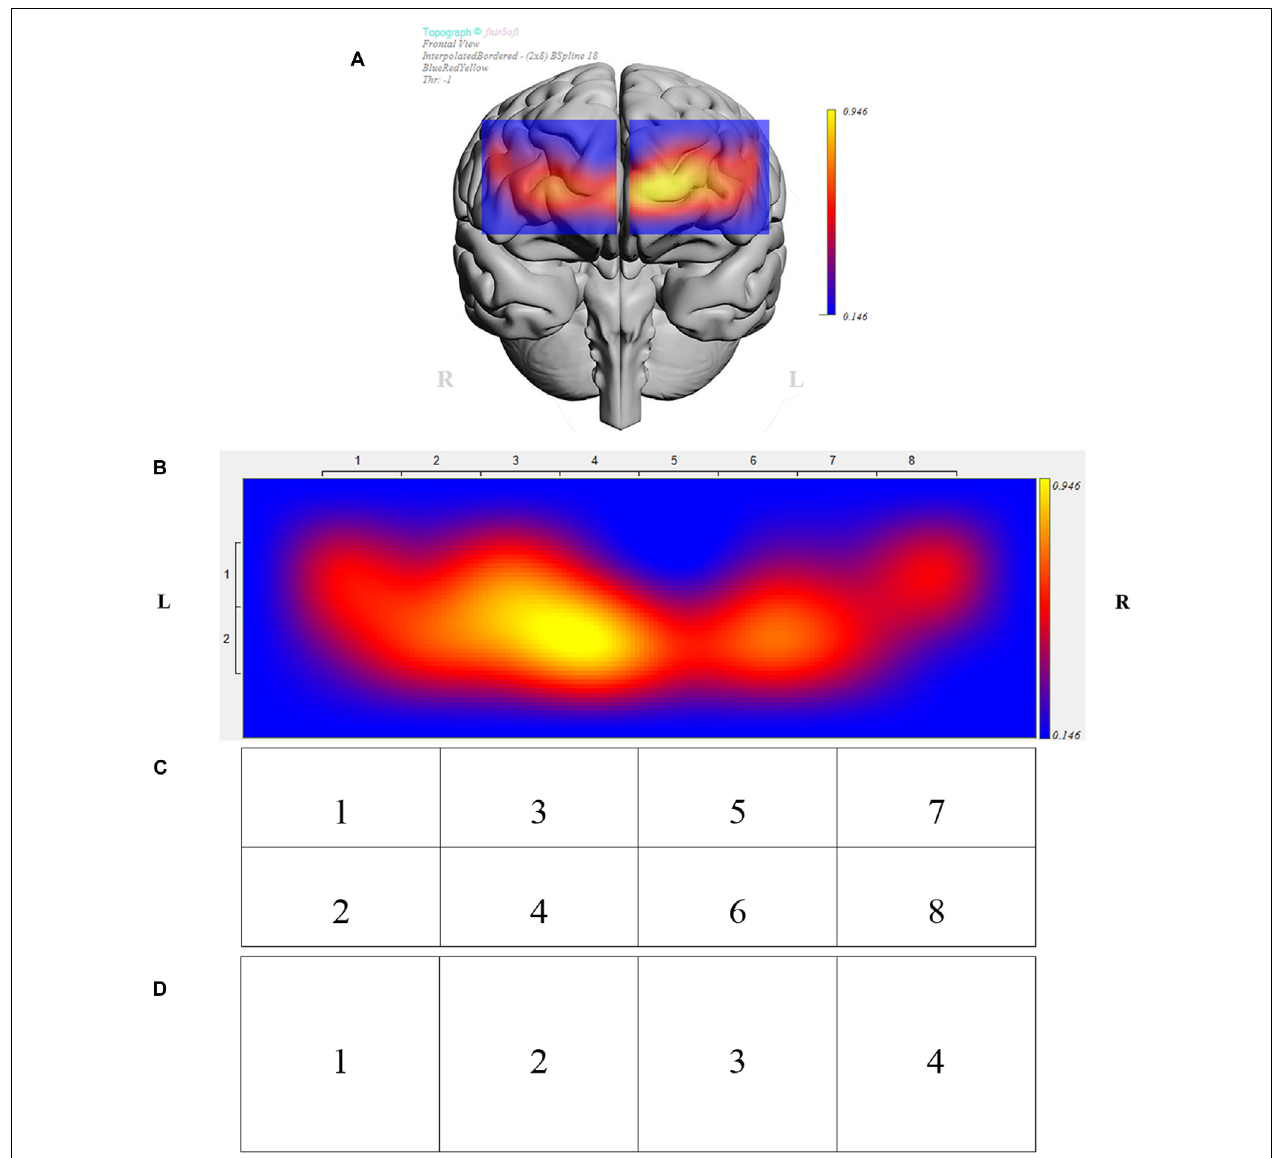
FIGURE 3 | (A) Brain template with data from sample participant depicting prefrontal regions under investigation. (B) Brain activity presented in 16 measurements locations (optodes) for the same participant. Data was further analyzed in clusters of eight regions (C) , and four regions (D) . (B–D) Depict opposite laterality from panel (A) , i.e., the right side of the figure corresponds to the right hemisphere and vice